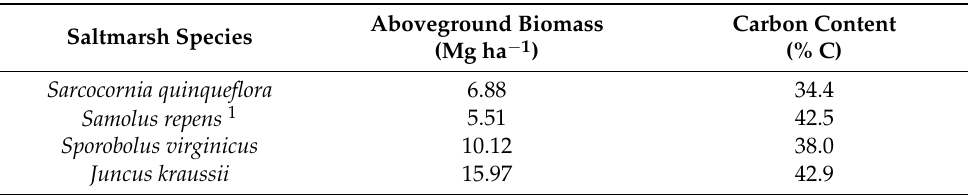
Table 1. Published values for aboveground biomass and carbon content for saltmarsh species in Jervis Bay [35].